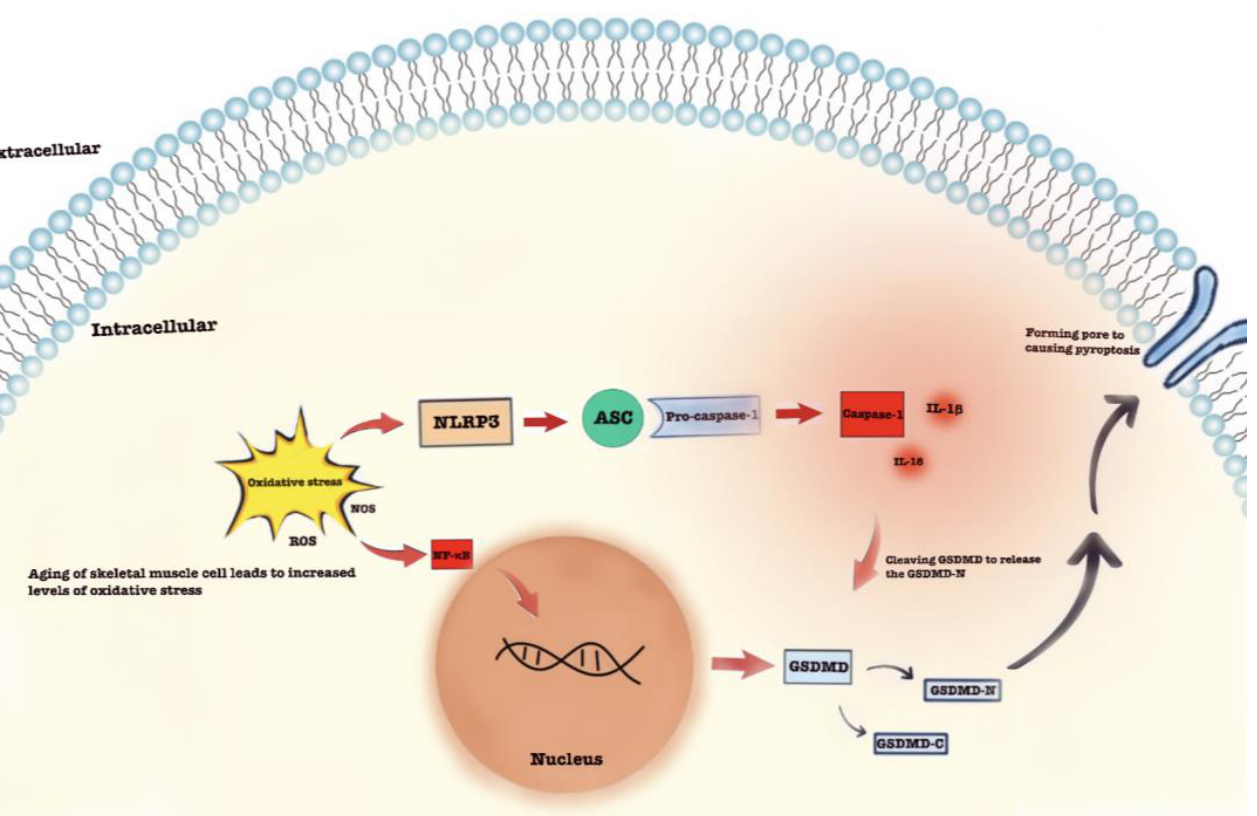
Figure 2. An increase in the level of oxidative stress caused by aging may trigger pyroptosis in skeletal muscle cells by the nuclear factor—kappaB (NF- κ B)—gasdermin D (GSDMD) Axis. NF- κ B is a transcription factor of GSDMD. When NLRP3 inflammasomes are activated by multiple activation mechanisms , the GSDMD will be subsequently cleaved, causing the release of the N-terminus of the GSDMD, which can form nanoscale pores in the cell membrane leading to the pyroptosis of skeletal muscle cells.